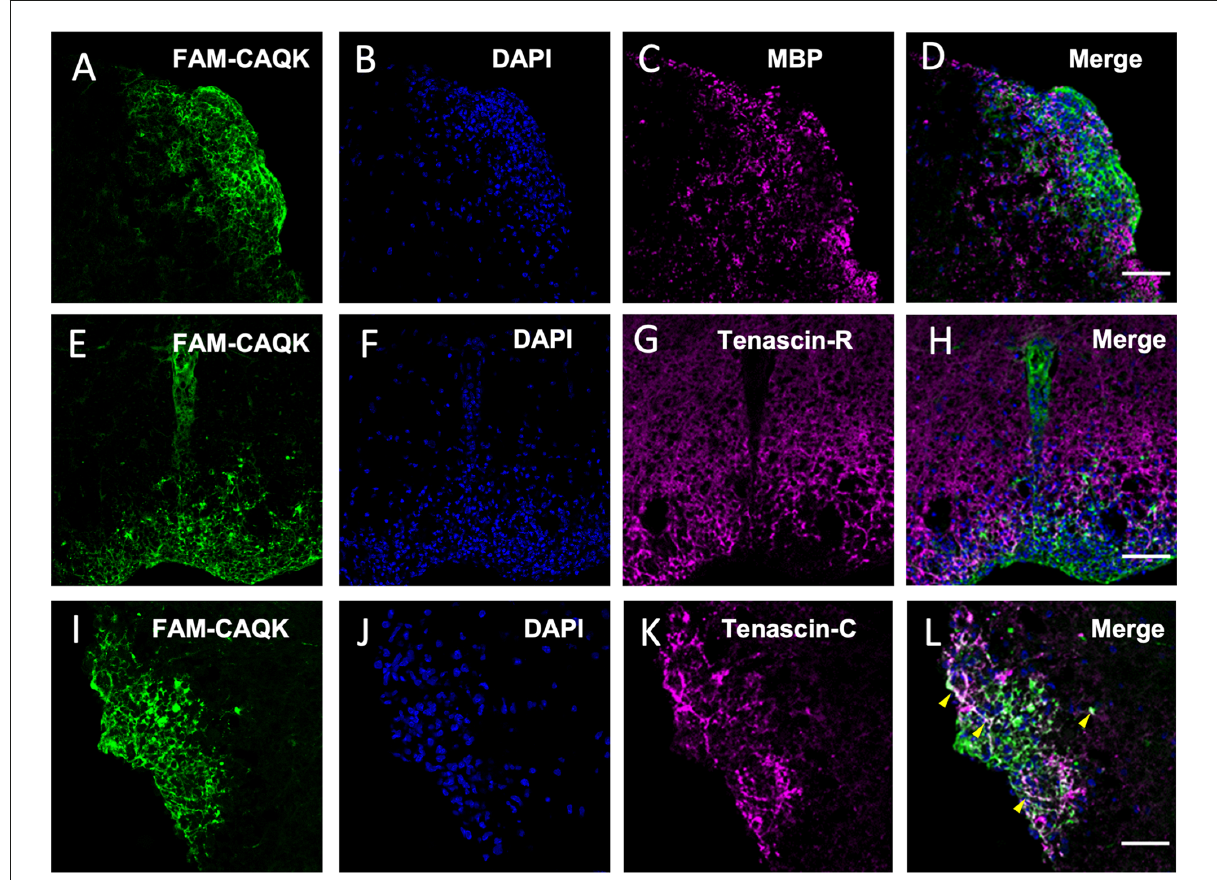
FIGURE7 CAQK and tenascins in EAE lesions. (A–D) Confocal images identify FAM-CAQK peptide ( A,E,I , green) at DAPI + lesion clusters ( B,F,J , blue) in the lumbar spinal cord of mice with EAE. The peptide does not associate with damaged myelin stained for MBP ( C , magenta; merge in D ) and largely complements staining for tenascin-R ( G , magenta; merge in H ). Some overlap is detected between FAM-CAQK and fibrous tenascin-C deposition ( K , magenta) as indicated by the white signal in the merged image ( L , arrowheads). Note that the majority of the lesion site covered by the peptide is negative for either tenascin (H,L) . Scale bars: 20 µ